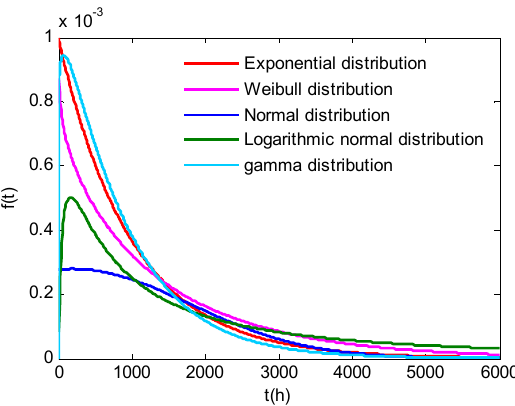
Figure 1. Typical probability density curves.